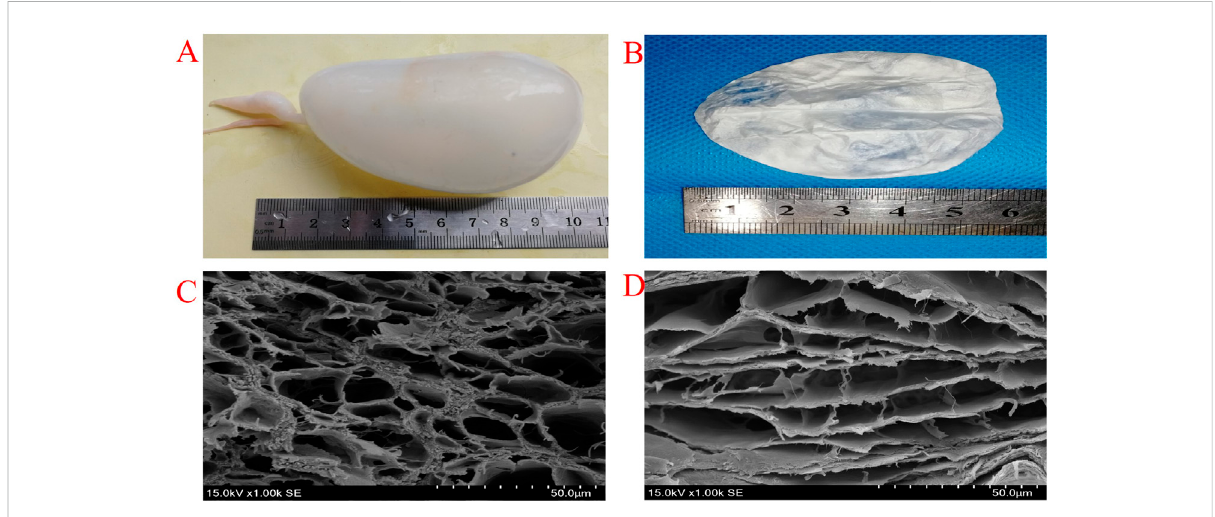
FIGURE 2 Photograph of fresh swimming bladders (A) EDC/NHS Cross-linking swimming bladders (B) SEM images of uncross-linked (C) and EDC/NHS cross-linked (D) swimming